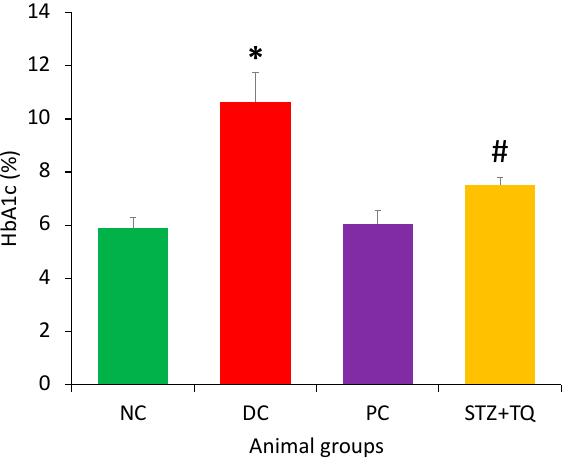
Figure 3. The percentage of HbA1c in different groups of rats after eight weeks of treatment. Rats were evenly divided into each group ( n = 8 per group). Data are means ± standard error of the mean (SEM). Groups: Normal control (NC); disease control (DC) i.e., STZ-treated group; positive control (PC) animal treated with STZ and Glibenclamide; diabetic animals treated with TQ (STZ + TQ). * p < 0.05 (significant difference of HbA1c percentage between DC vs. NC), # p < 0.05 (significant difference of HbA1c percentage between DC vs. STZ + TQ).